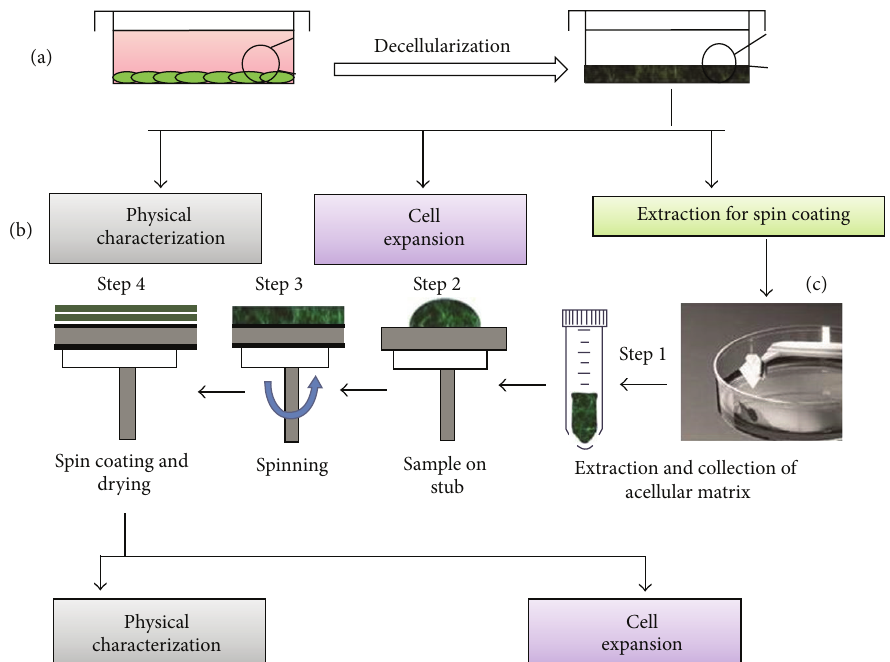
Figure 1: Preparation of spin coated HS-5 acellular matrices. (a) Decellularization of HS-5 cells. (b) Physical characterization of the acellular matrices. (c) Spin coating process: step 1—extraction and collection of acellular matrices, step 2—sample kept on tissue culture surfaces to be coated, which is held in vacuum on a stub, step 3—spinning at fixed rpm, and step 4—coating and drying under sterile